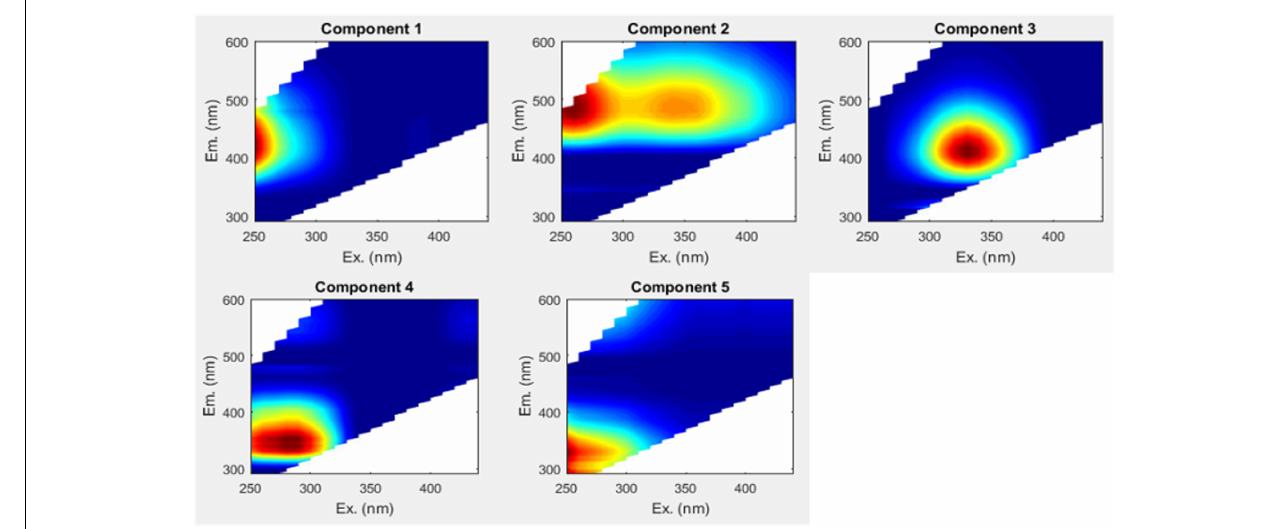
FIGURE 4 | Five PARAFAC components were optimally identified.